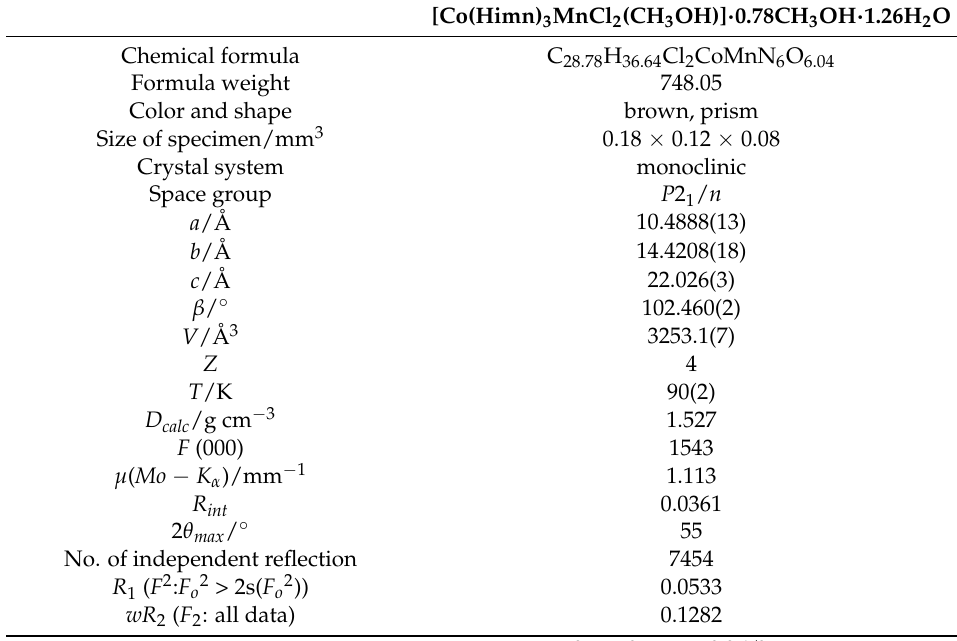
Figure 1. The molecular structure of [Mn{Co( µ -Himn) 3 }Cl 2 (CH 3 OH)] (50% probability levels). Hydrogen atoms have been omitted for clarity. The disordered C atom of the coordinating methanol molecule is shown at the two possible positions (C28 and C28B). Table 1. Crystallographic information.